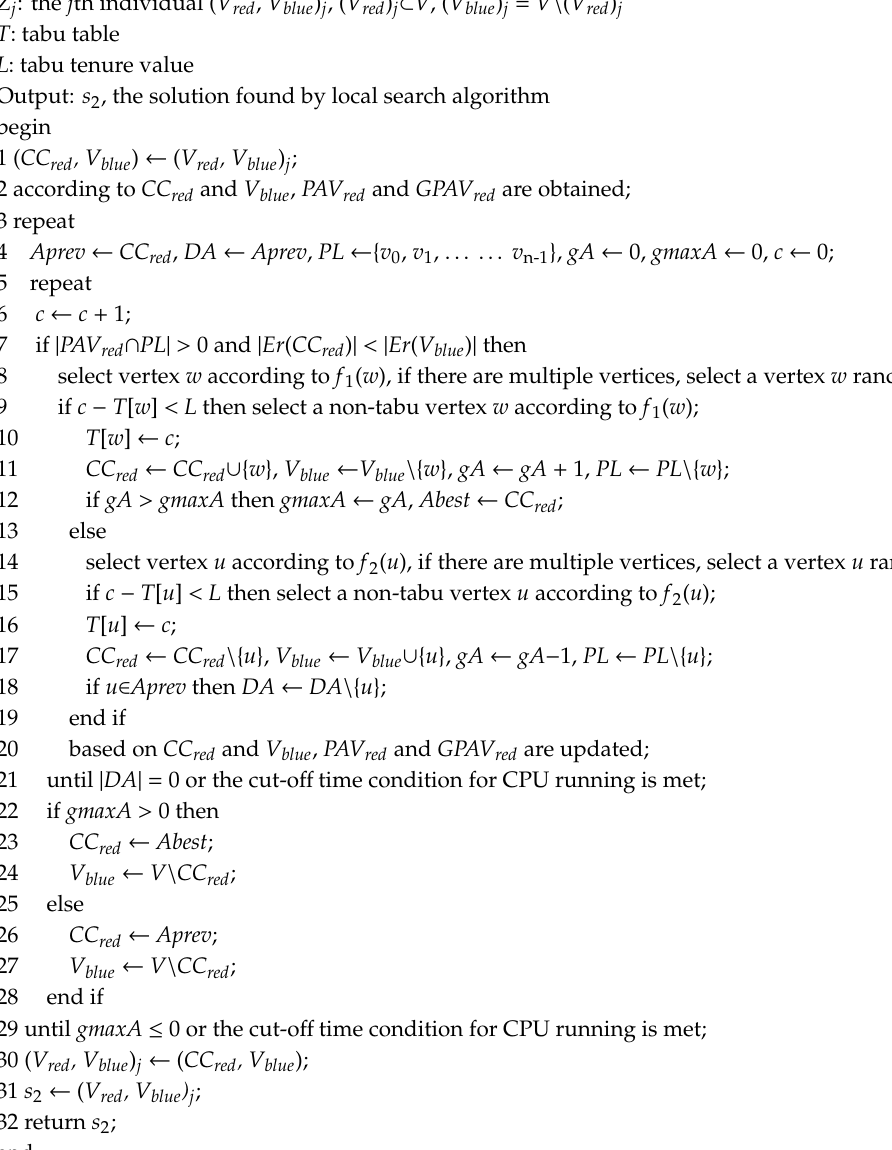
Algorithm 2 New_K-OPT_MLCP ( G , Z j , T , L